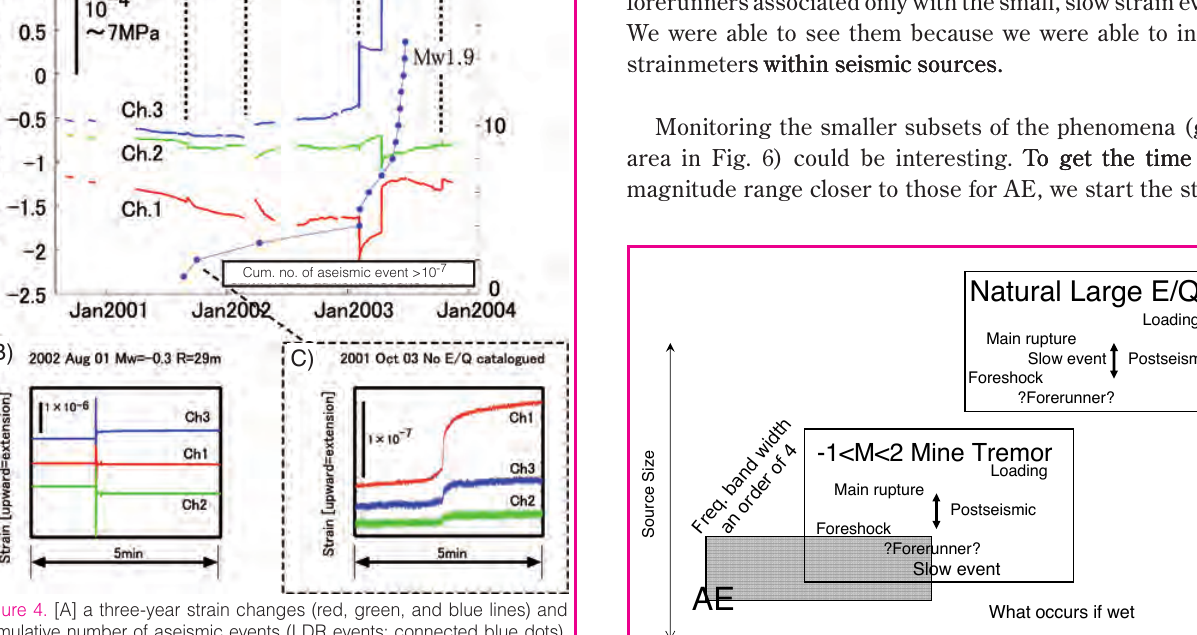
cumulative number of aseismic events (LDR events; connected blue dots).